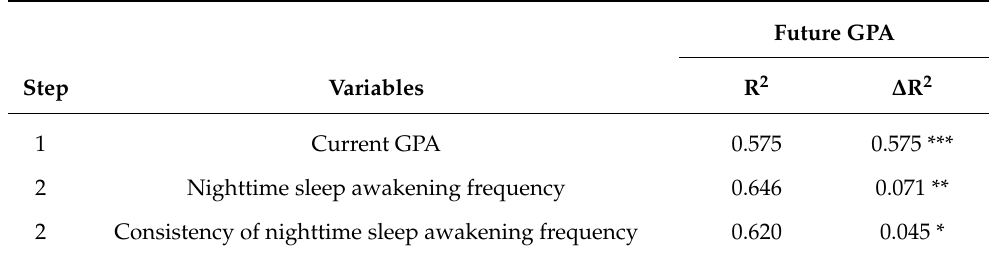
Table 3. Hierarchical regression analyses predicting cumulative GPA from semester GPA and night- time sleep awakening